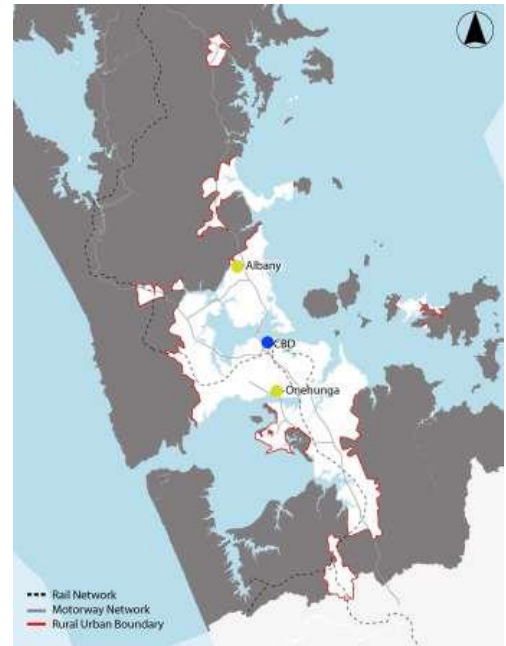
Figure 1. Auckland urban region showing the CBD (blue), and in red, Albany to the North and Onehunga to the south.